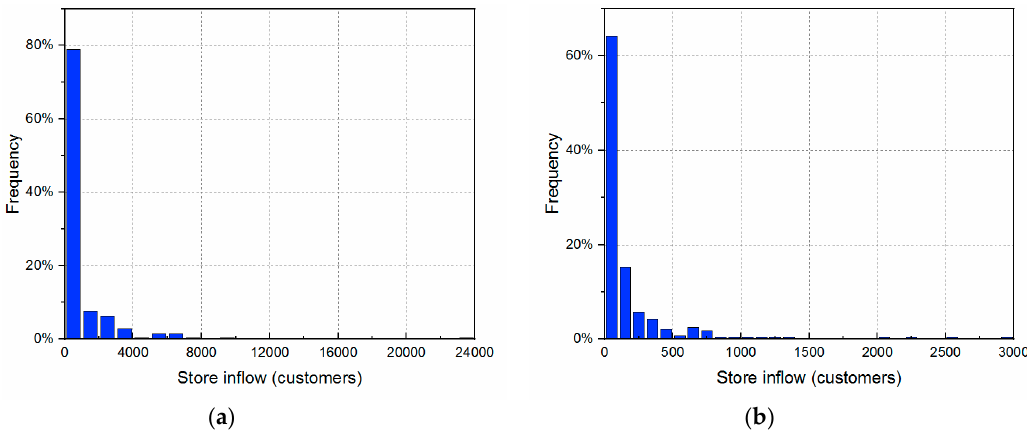
Figure 6. Boxplot of store inflow.